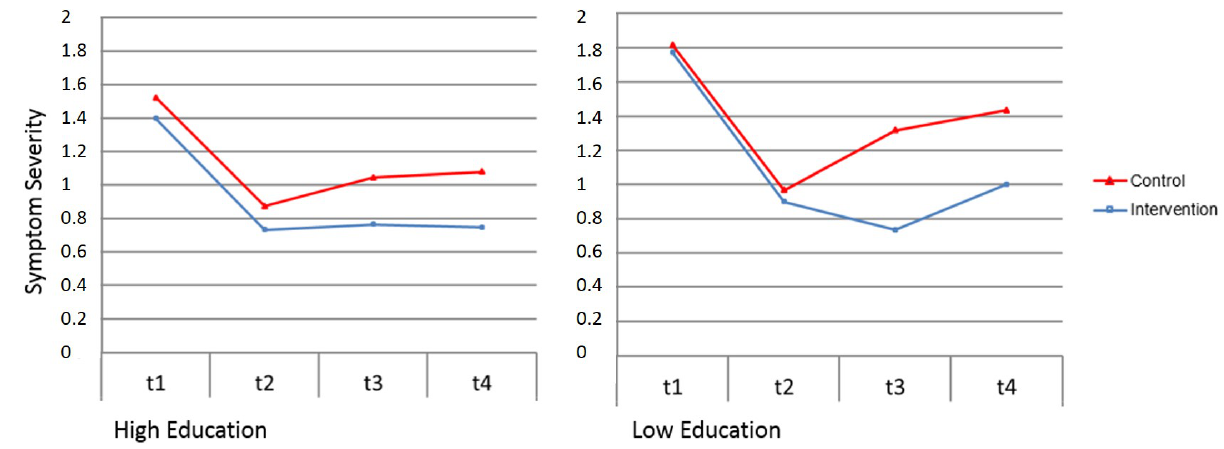
Figure 2. Estimated course of symptoms based on simple slope mixed-effect model analysis for significant moderators effect of education (0=high education, n=159; 1=low education, n=57) at inpatient admission (T1), inpatient discharge/begin transdiagnostic Internet-based maintenance treatment (T2), 3-month follow-up/end transdiagnostic Internet-based maintenance treatment (T3), and 12-month follow-up (T4).